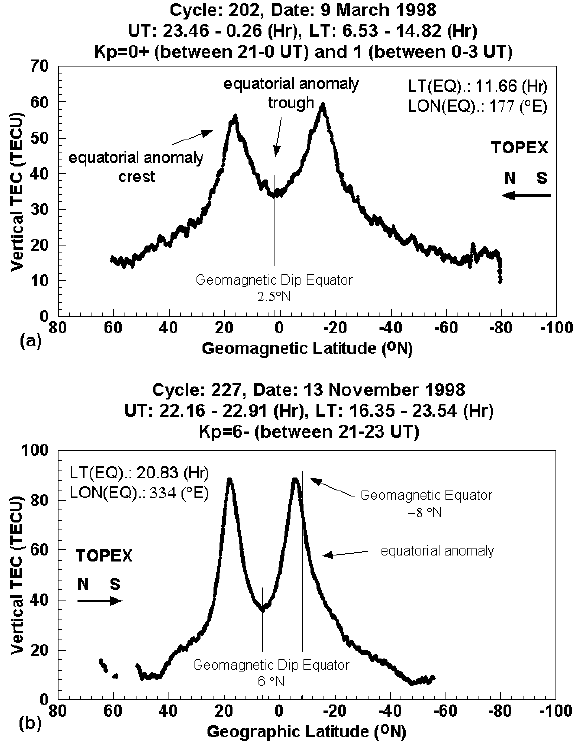
Fig. 1. The TOPEX TEC plots show the equatorial anomaly (a) in geomagnetic latitudes at 177 ◦ E (geographic), where the offset between the geomagnetic and dip equators is small and (b) in geographic latitudes at 334 ◦ E (geographic), where this offset is larger. (LT(EQ) = geographic equator crossing local time, LON(EQ) = equator crossing longitude, geographic, the arrow indicates the satellite travelling